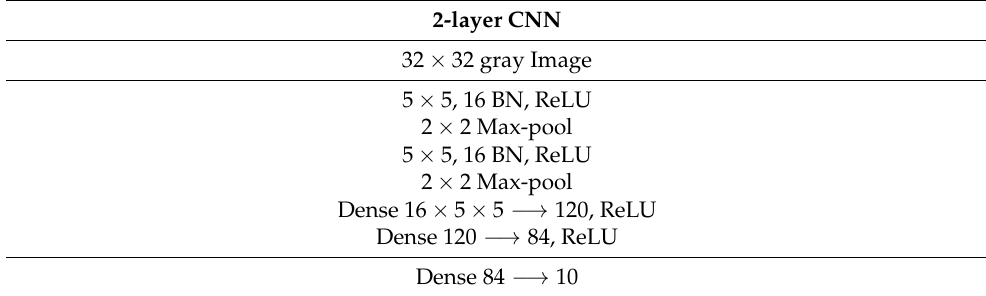
Table 1. The structure of 2-layer